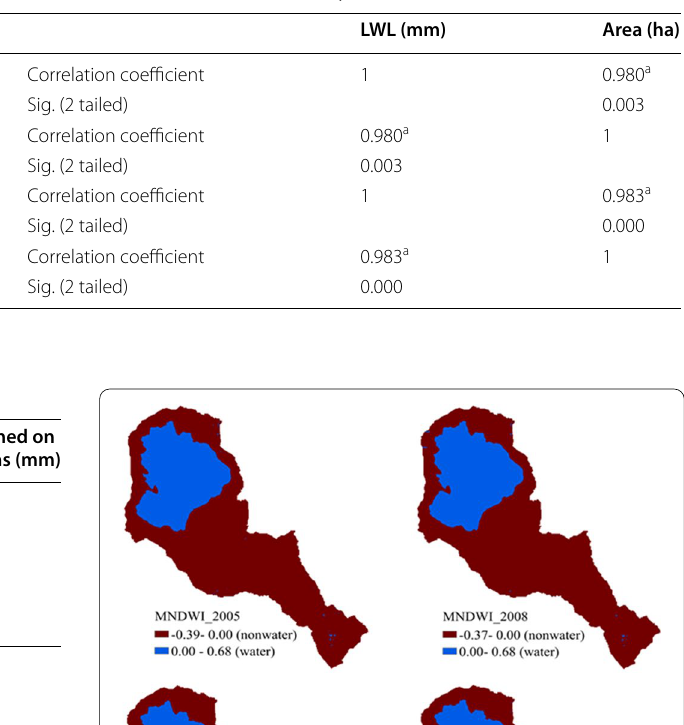
Table 7 The Correlation between gauge station lake levels and MNDWI index extracted remotely sensed water areas (2005–2011)